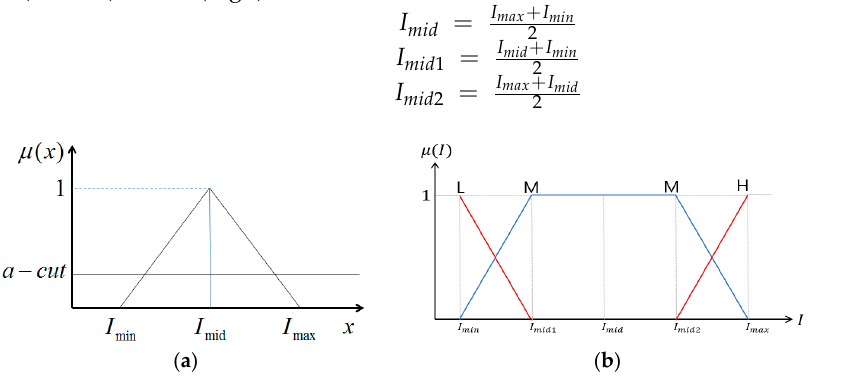
Figure 1. Fuzzy membership function for fuzzy brightness stretching. ( a ) Triangle membership function [24], ( b ) trapezoid membership function (proposed).